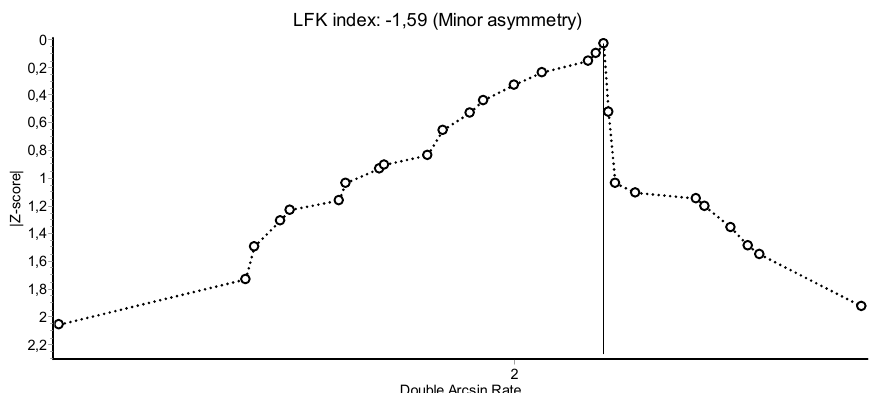
Figure A6. Doi plot analysis and Luis Furuya-Kanamori asymmetry (LFK) index of publication bias for the pooled abstinence rate.